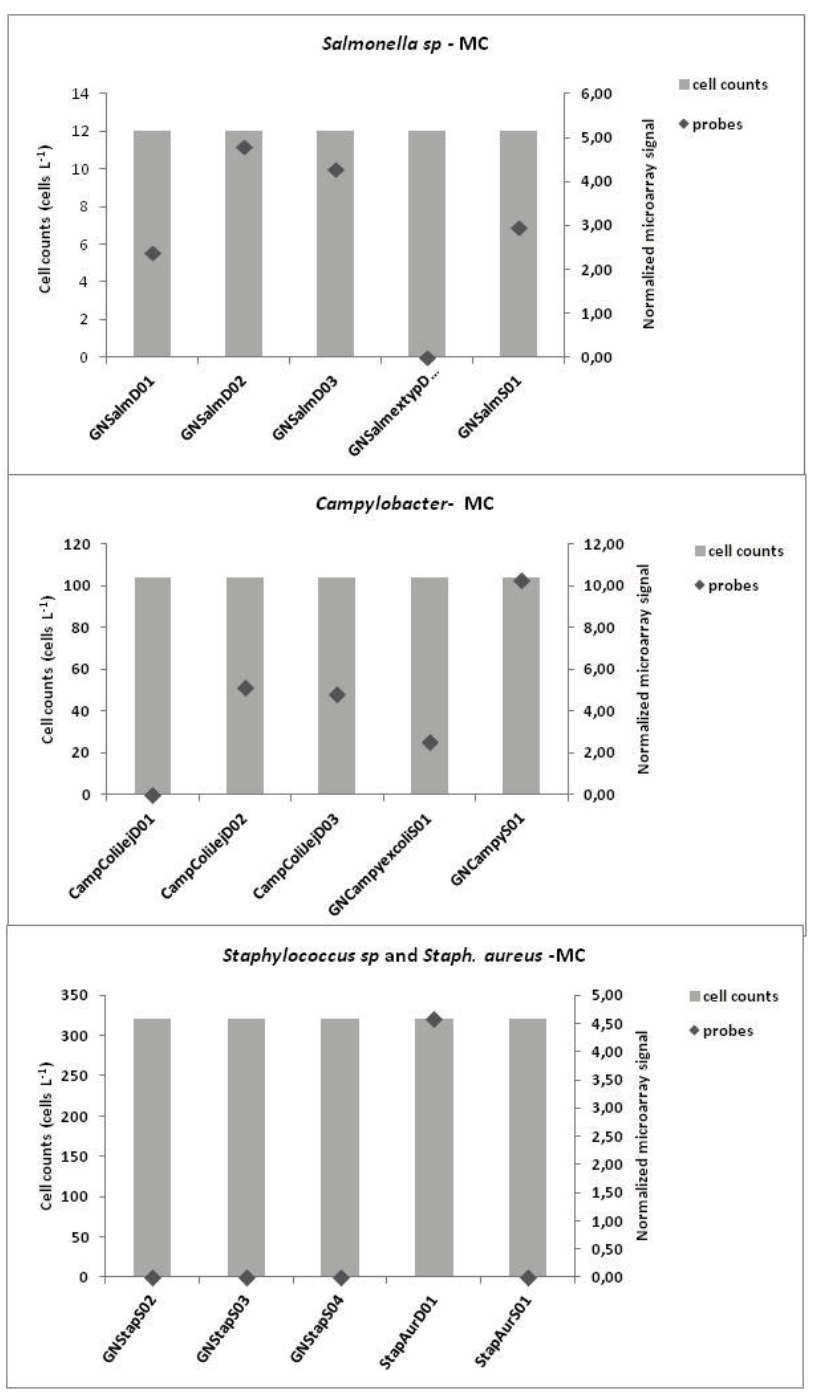
Figure 7. Comparison of concentrations of microorganisms and signal point measurement probes for each probe at the Mezzocammino